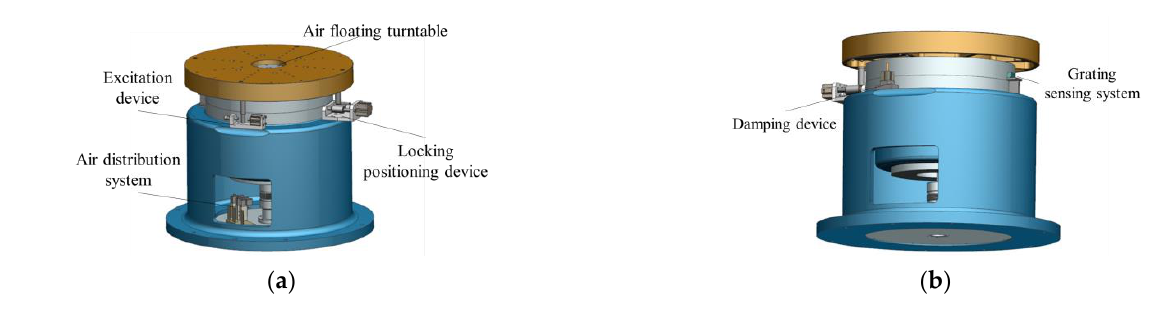
Figure 10. (a) Front view of the MOI measurement mechanism model.; ( b ) Rear view of the MOI measurement mechanism model. measurement mechanism model.